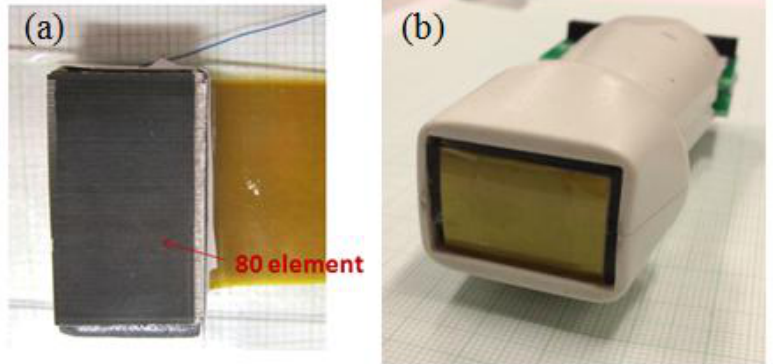
Figure 18. Photographs of the 80-element phased array ( a ) before and ( b ) after adding a lens and housing.